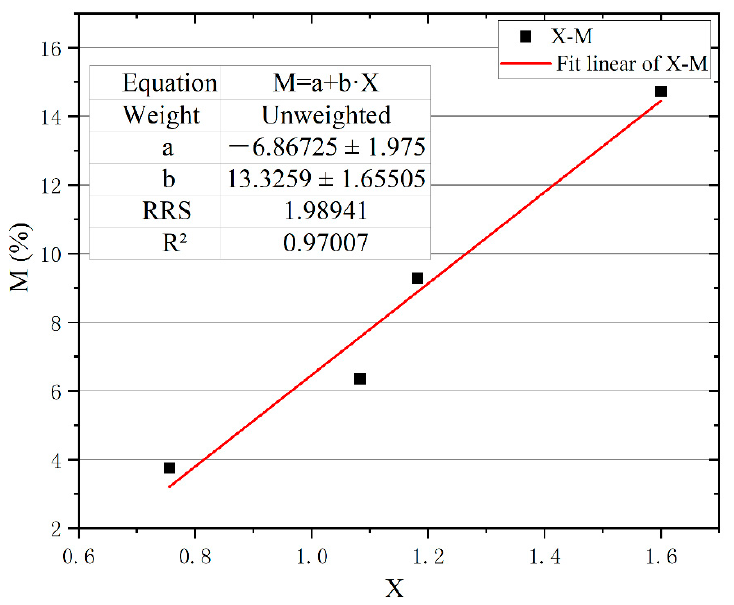
Figure 7. Regression analysis of microstructure parameters and residual ash.